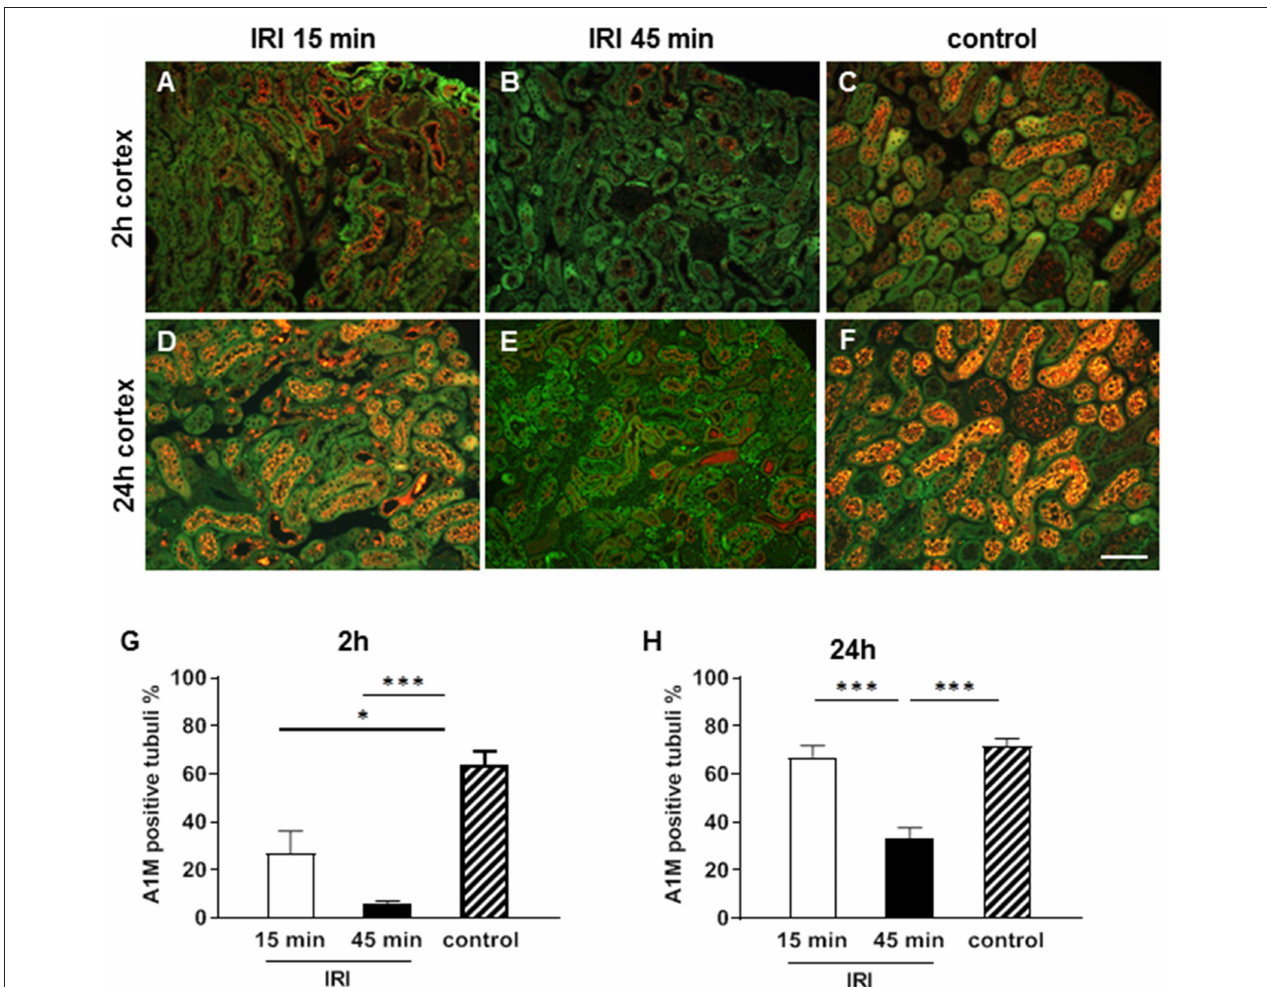
FIGURE 4 | Tubular function at two (A–C,G) and 24h (D–F,H) after IRI. A1M is reabsorbed from the intact tubuli and is stained in small vesicles in the cytoplasm of 70% of the proximal tubuli in the cortex in the healthy state (C,F) . Already after 2h after short IRI A1M expression was moderately reduced (A) and after 45min IRI normal vesicular A1M staining was almost absent in the pTECs (B) . At 24h vesicular A1M staining was normal again in the short term IRI group (D) and significantly reduced in the prolonged IRI group ( E , bar: 100 µ m, mean ± SEM, * p < 0.05, *** p < 0.001, n = 6 mice/group, one way